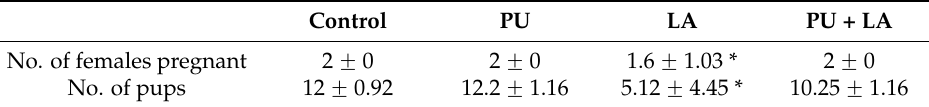
Table 3. Mating test (mean ˘